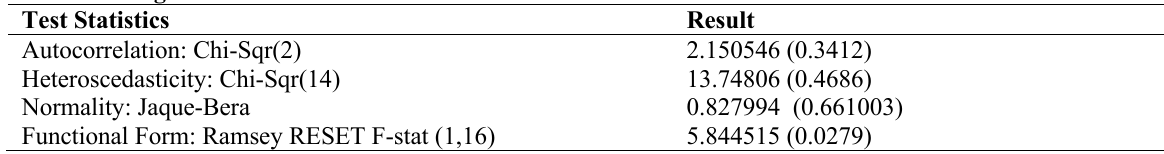
Table 6: Diagnostic Tests Test